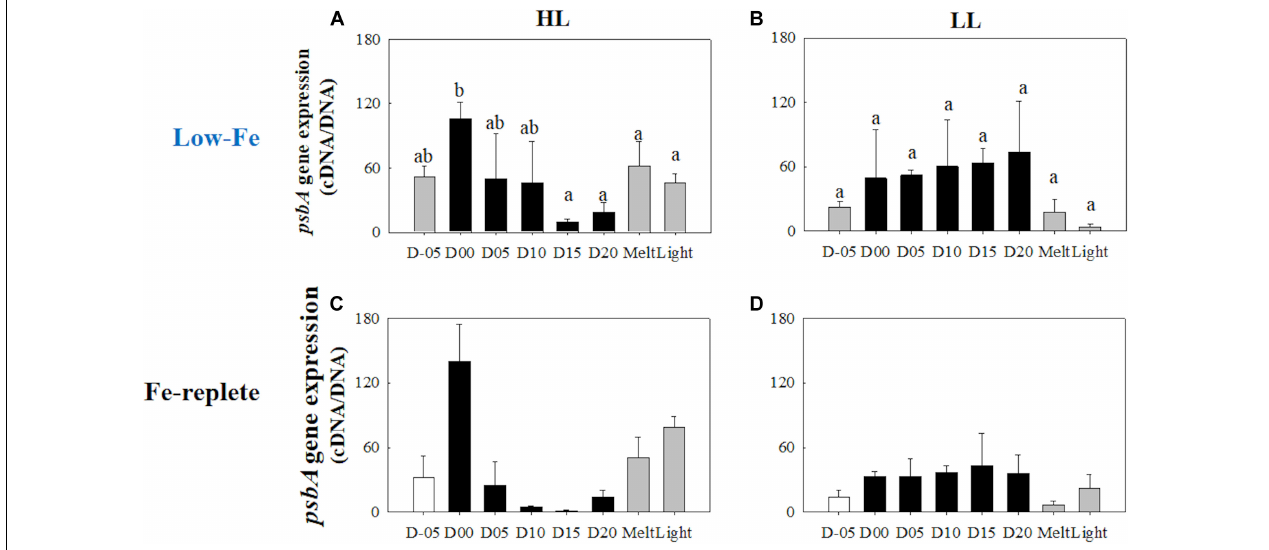
FIGURE 13 | Gene expression of the psbA gene. Panels (A,B) show psbA gene expression of the low-Fe ice tank runs in this study, whereas panels (C,D) show those of Fe-replete ice tank runs modified from Yoshida et al. (2020). Left (A,C) and right (B,D) panels indicate data from the HL and LL treatments, respectively. Open, closed, and shaded bars indicate values of pre-freeze seawater, ice, melted seawater samples, respectively. Letters above bars in a panel indicate significant differences in values between sampling days with one-way ANOVA with Tukey’s test; there is no significant difference between values if a given letter is shown in the combination of letters of the counterparts. The D stands for “day,” while Melt and Light indicate values after melting and light exposure experiments, respectively. Error bars show 1 standard deviation ( n = 3). One-way ANOVA with Tukey’s test, HL: F ( 7 , 23 ) = 4.65, p = 0.005; LL: F ( 7 , 23 ) = 2.33, p > 0.05. Two-way ANOVA test with Tukey’s test, Light: F ( 1 , 45 ) = 3.82, p > 0.05; Day: F ( 7 , 45 ) = 2.58, p = 0.036; Light*Day: F ( 7 , 45 ) = 3.16, p = 0.014. The results of Tukey’s test, as q -values, are given in the